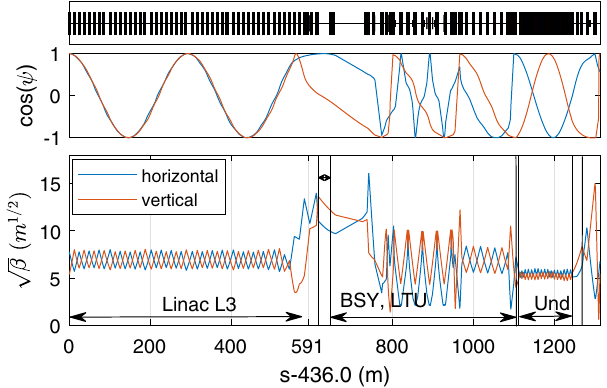
FIG. 4. Linear optics for LCLS from BC2 to the dump. Top: the cosine of the betatron phase advance. Bottom: square root of beta ffiffiffiffiffiffiffi p β functions ( x;y